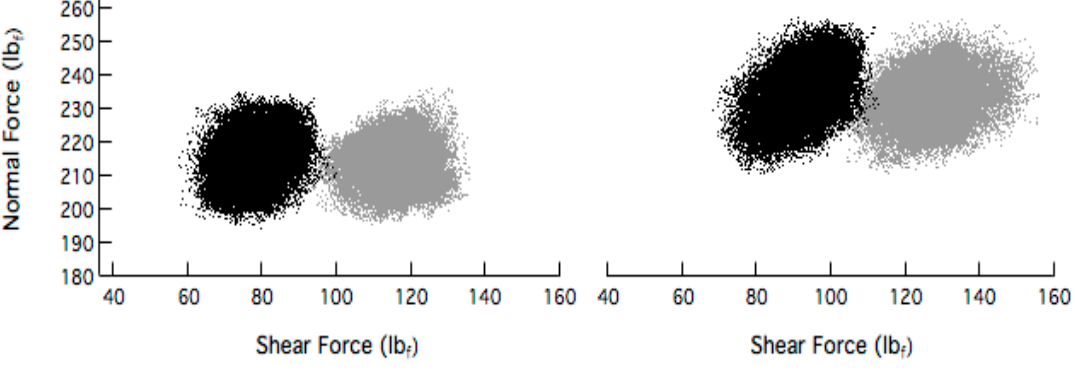
Figure 4. Shear force and normal force scatter plot for copper CMP processes resulting from Disc A (gray) and Disc B (black). The wafer polishing pressures and pad-wafer sliding velocities are 2.1 psi–1.4 m/s ( left ) and 2.3 psi–1.6 m/s ( right ).